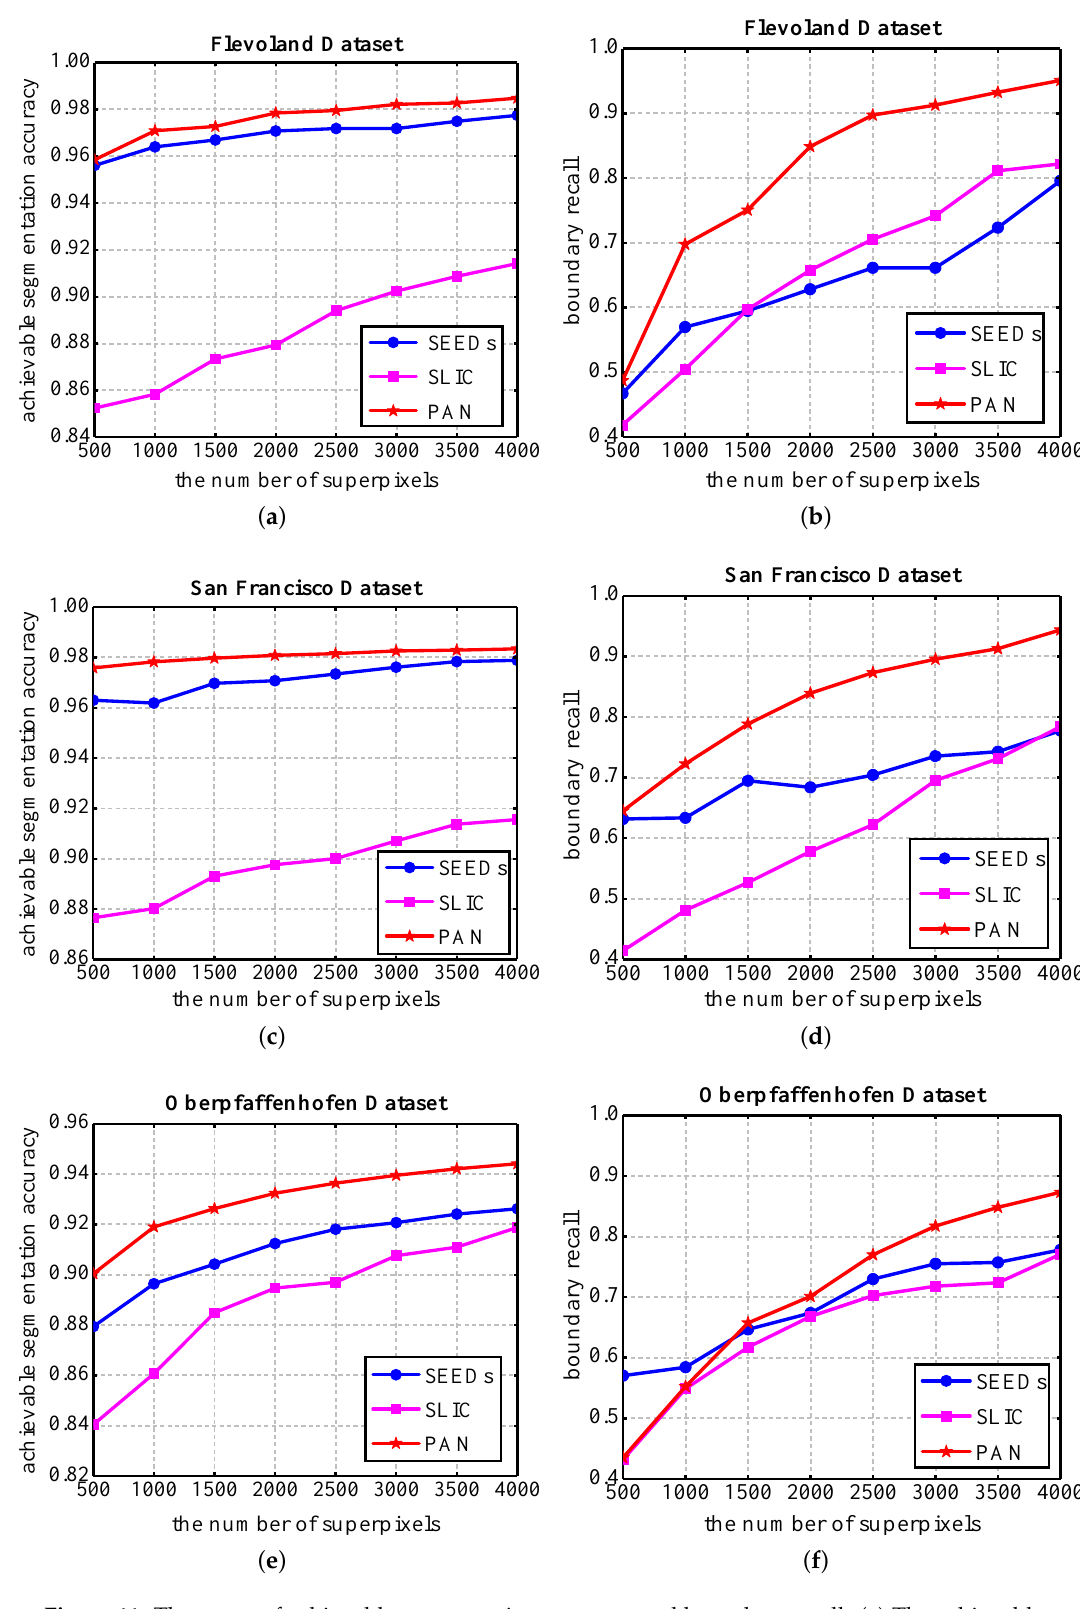
Figure 11. The curve of achievable segmentation accuracy and boundary recall. ( a ) The achievable segmentation accuracy on Flevoland data set. ( b ) The boundary recall on Flevoland data set. ( c ) The achievable segmentation accuracy on San Francisco data set. ( d ) The boundary recall on San Francisco data set. ( e ) The achievable segmentation accuracy on Oberpfaffenhofen data set. ( f ) The boundary recall on Oberpfaffenhofen data